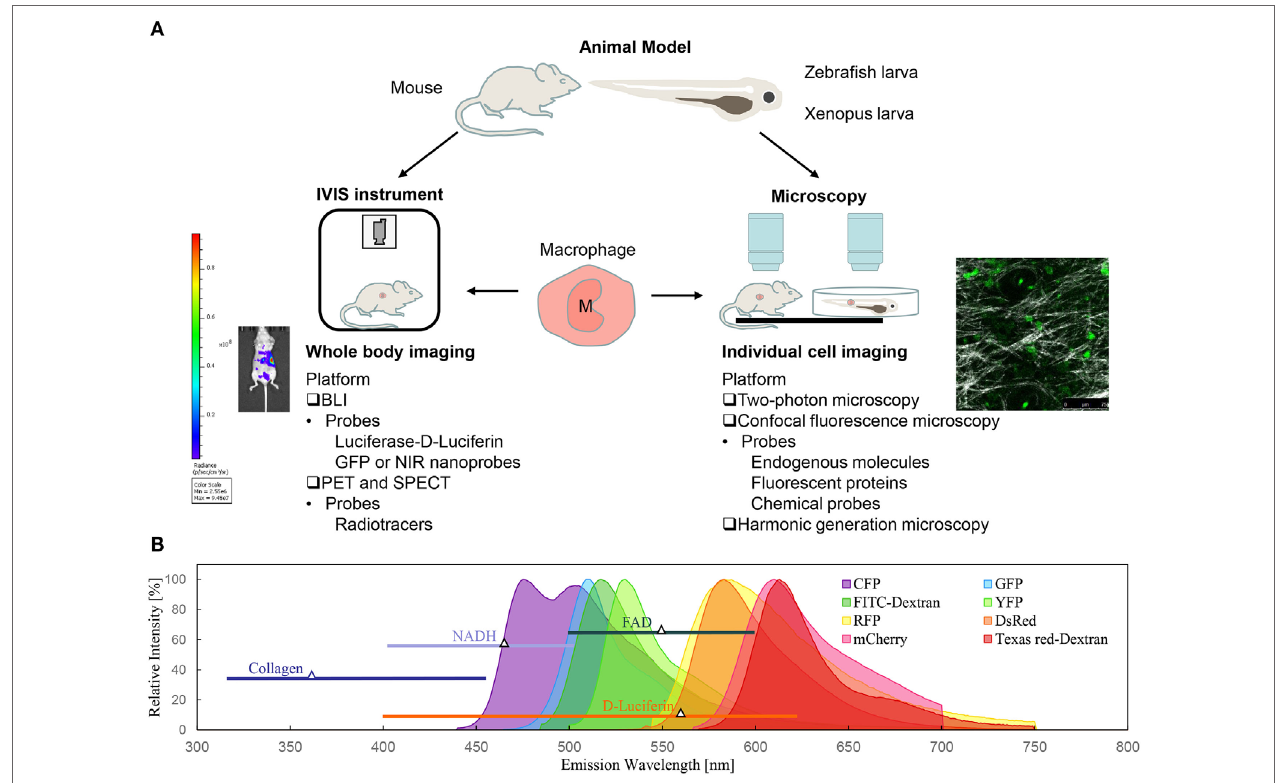
FiGURe 1 | Optical imaging techniques for macrophage tracking in vivo . (a) Bioluminescence imaging (BLI) and intravital microscopy are the two of most commonly used non-invasive optical techniques for macrophage imaging in animal models. (b) Spectra of fluorescent probes for macrophage labeling: intrinsic components (NADH, FAD, and collagen), genetic probes (fluorescent proteins), and commercial chemical probes (fluorescent dye-dextran